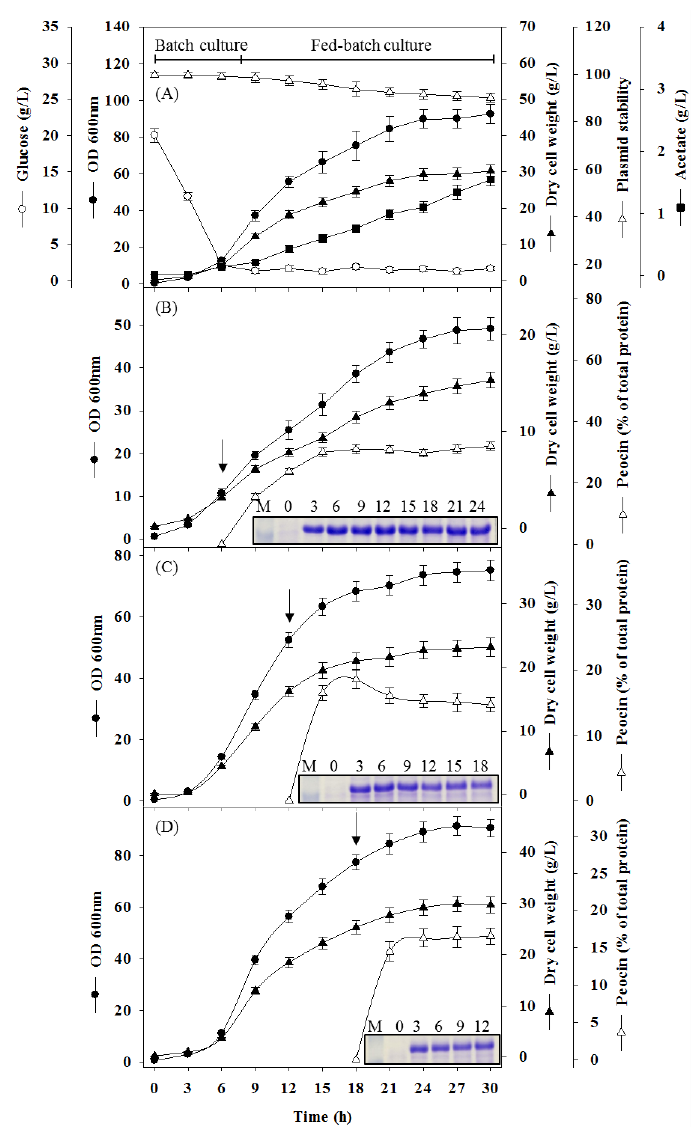
Figure 4. ( A ) Fed-batch cultivation of recombinant E. coli BL(DE3)/pET-peocin with a pH-stat without IPTG induction. Cell density OD 600 (●), dry cell weight ( ▲ ), glucose ( ○ ), plasmid stability ( △ ), and acetic acid ( ). Fed-batch cultivation with IPTG induction at ( B ) early log phase (6 h), ( C ) midlog phase (12 h), and ( D ) late log phase (18 h). Cell density OD 600 (●), dry cell weight ( ▲ ), and ggGH content ( △ ). The arrow indicates the time of IPTG induction. SDS-PAGE for peocin content analysis is shown in the bottom right corner. Lane M indicates the molecular mass standard; the numbers indicate the hours post induction.